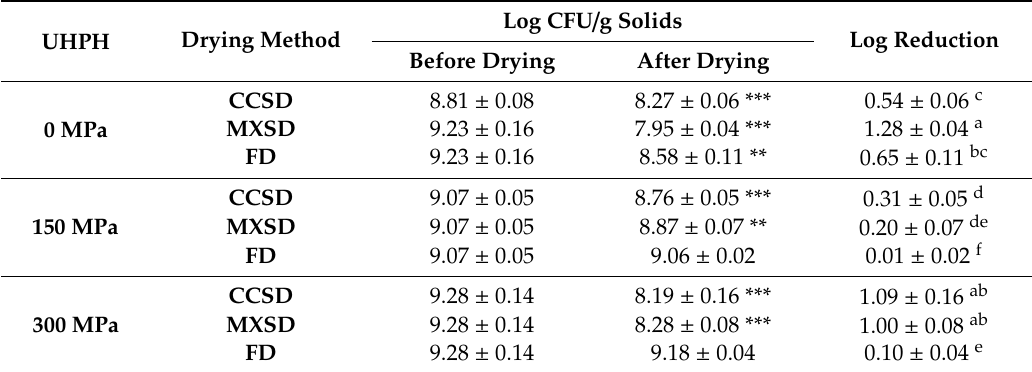
Table 1. Cell counts (Log CFU / g solids) of L. plantarum NRRL B-1927 in liquid dispersions and powders †